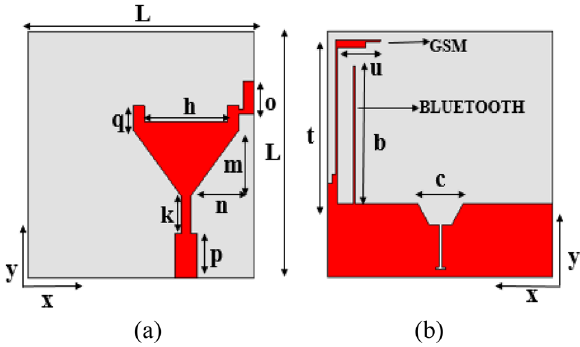
Figure 1. Proposed antenna element: ( a ) front view and ( b ) back view.